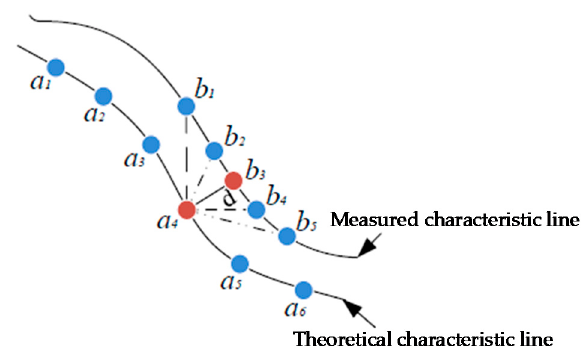
Figure 6. Minimum area assessment.